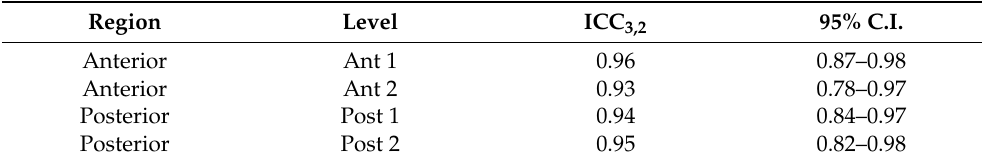
Table 7. Intra-rater reliability of the ultrasound measurements within different regions/levels of the superficial fascia of the arm between two sessions by